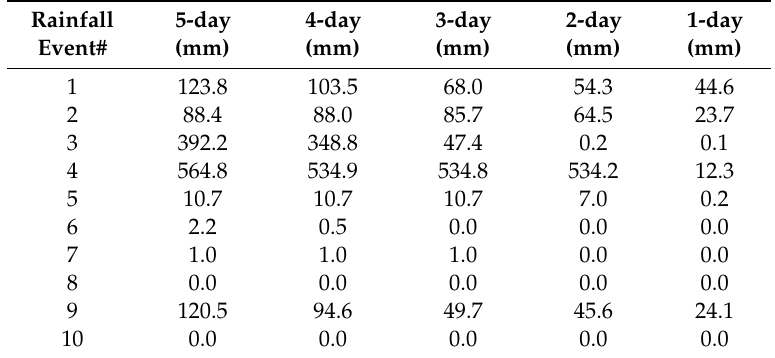
Table 5. Antecedent n-day rainfall amount for each rainfall event considered in this